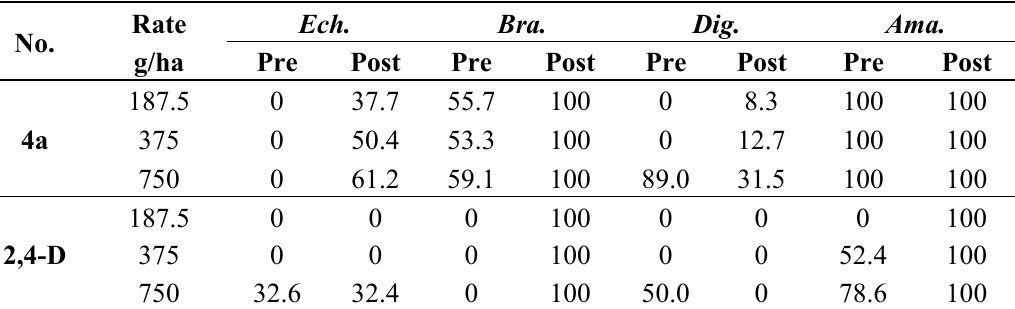
Table 3. Herbicidal activities of compound 4a and 2,4-D (percent inhibition, %). Rate No. g/ha